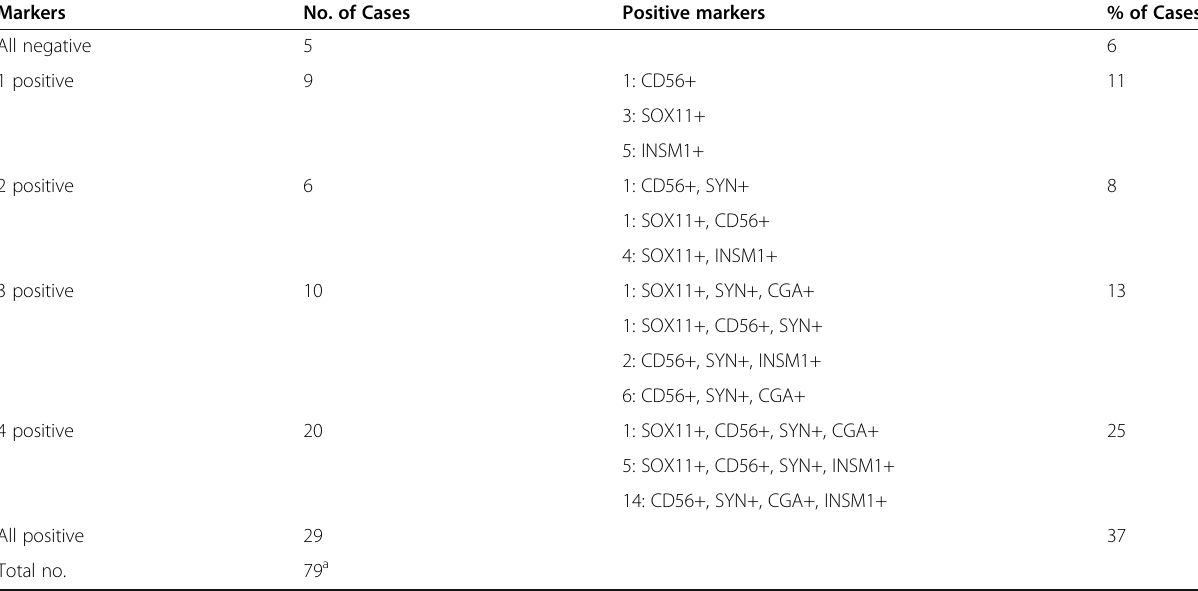
Table 3 Immunoreactivity for Neuroendocrine Markers in SCLC Markers